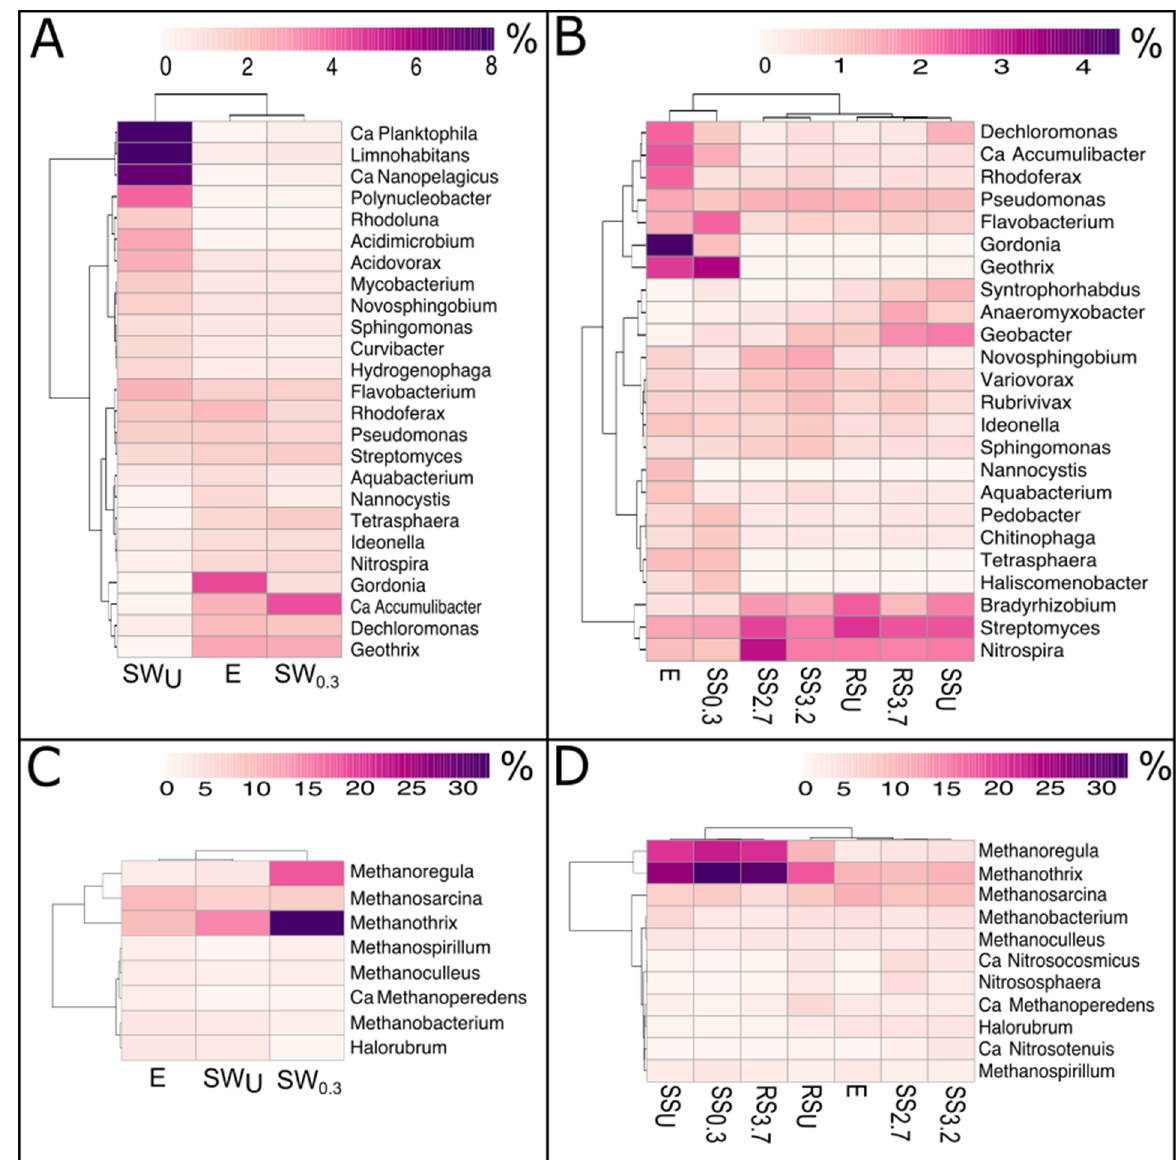
Figure 2. Heatmaps showing the proportions of major bacterial ( A , B ) and archaeal ( C , D ) genera (>1% and >3% in at least one sample, respectively) in the bacterial and archaeal communities of water ( A , C ) and sediment ( B , D ) samples. E is the effluent of the wastewater treatment plant (WWTP), SW and RW are the water samples and SS and RS are the sediment samples of the stream and river, respectively. SW U and SS U are the samples taken upstream of the WWTP discharge point, and RW U and RS U are the samples taken from the river upstream of the stream inflow point. The number in the subscript of the sample code shows the distance (km) of the sampling point downstream from the WWTP discharge point.